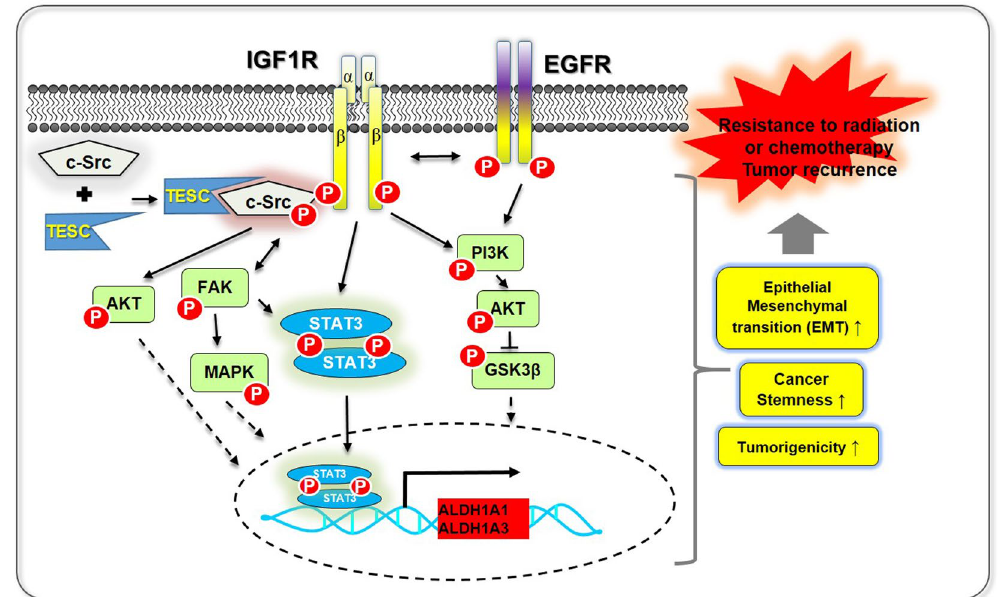
Figure 7. Schematic overview showing TESC/c-Src/IGF1R-mediated STAT3 activation in NSCLC cells. TESC induces tumorigenesis and resistance to radiation through recruiting c-Src, a proto-oncogene tyrosine-protein kinase, to form TESC/c-Src/IGF1R complex and activating IGF1R. The activated IGF1R phosphorylates STAT3, which results in its nuclear translocation and the conduction of coactivator function to activate the transcription of ALDH1 isozymes. Because TESC affects IGF1R and c-Src, TESC may be involved in the other signaling pathways such as AKT, FAK and EGFR.